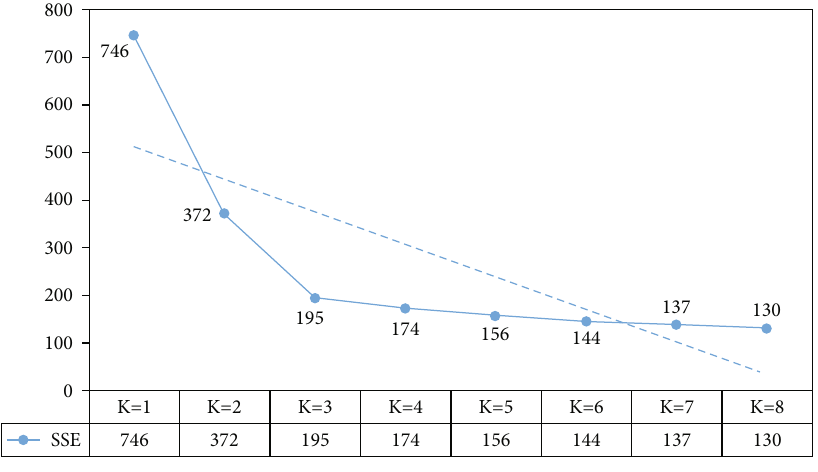
Figure 4: Plot of the minimum error sum of squares versus the number of clusters K .